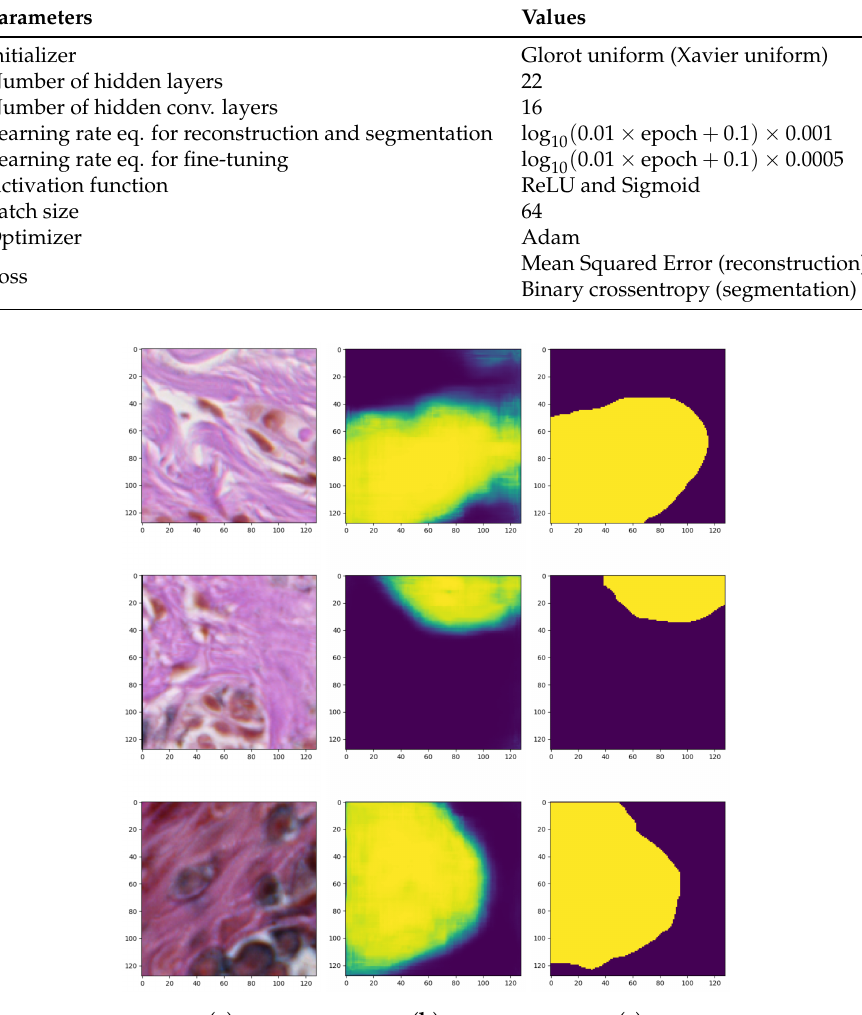
Table 1. Parameter settings of the autoencoder.